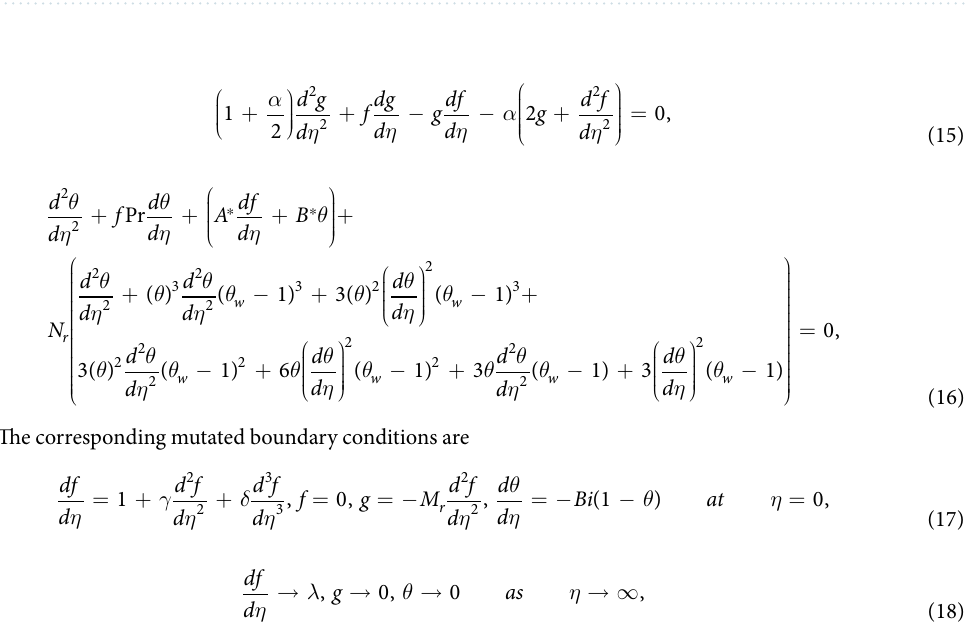
Figure 8. Curves of temperature with the variant in ( a ) A * ( b ) B *